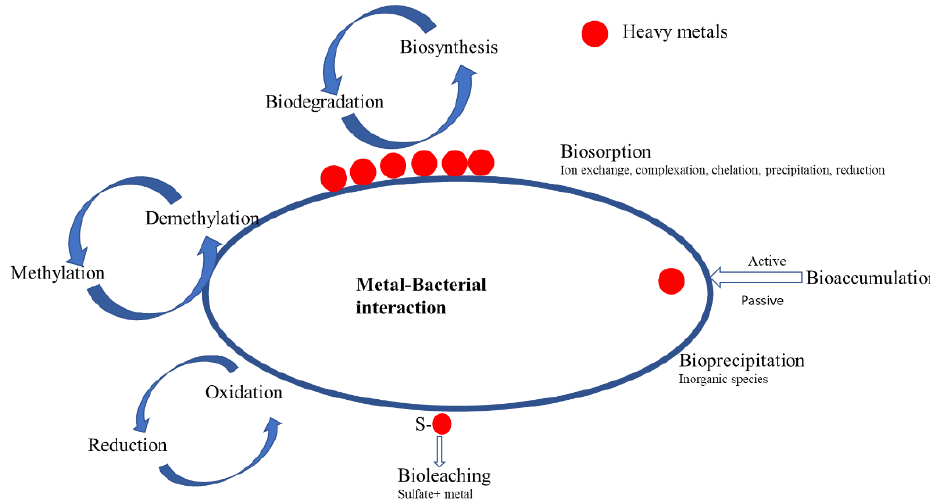
Figure 1. Diagram depicting interaction between bacteria and metal species edited from [26].